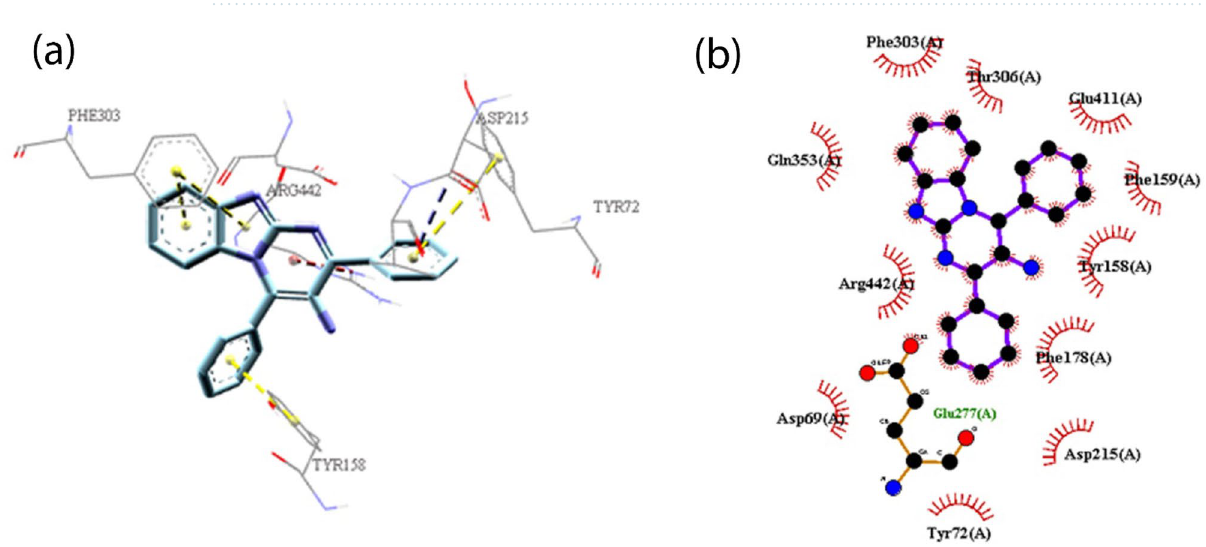
Figure 5. ( a ) The 3D and ( b ) 2D predicted binding mode of the compound 3a in the active site pocket (π–π: yellow, π-Anion: blue, π-cation: red, hydrophobic: pink). *This figure was created by using Discovery Studio 4.0 Client (https:// disco ver. 3ds. com/ disco very- studio- visua lizer- downl oad) and LigPlot (https:// www. ebi. ac. uk/ thorn ton- srv/ softw are/ LigPl us/ downl oad.